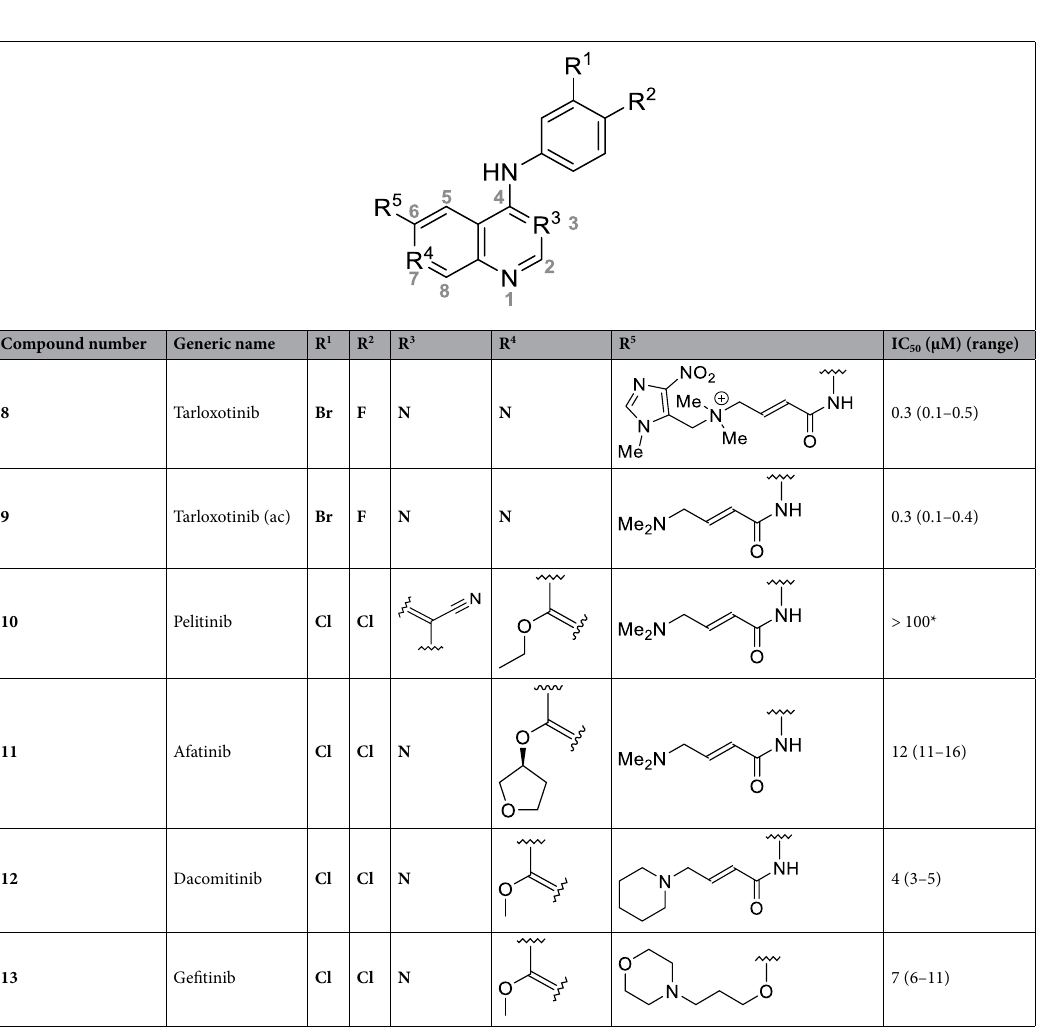
Table 1. Structure–activity relationship of 4-aminoquinazoline EGFR inhibitors against SARS-CoV-2 PL pro . *The range could not be established due to lack of